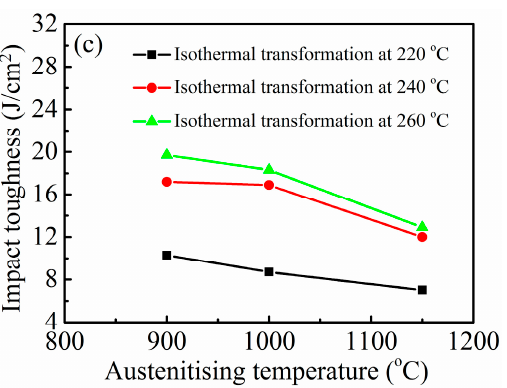
Figure 6. ( a ) Strength; ( b ) hardness; and ( c ) impact toughness as a function of austenitising temperature for isothermally transformed samples. Note that tensile strength and yield strength are represented in solid and open symbols, respectively.